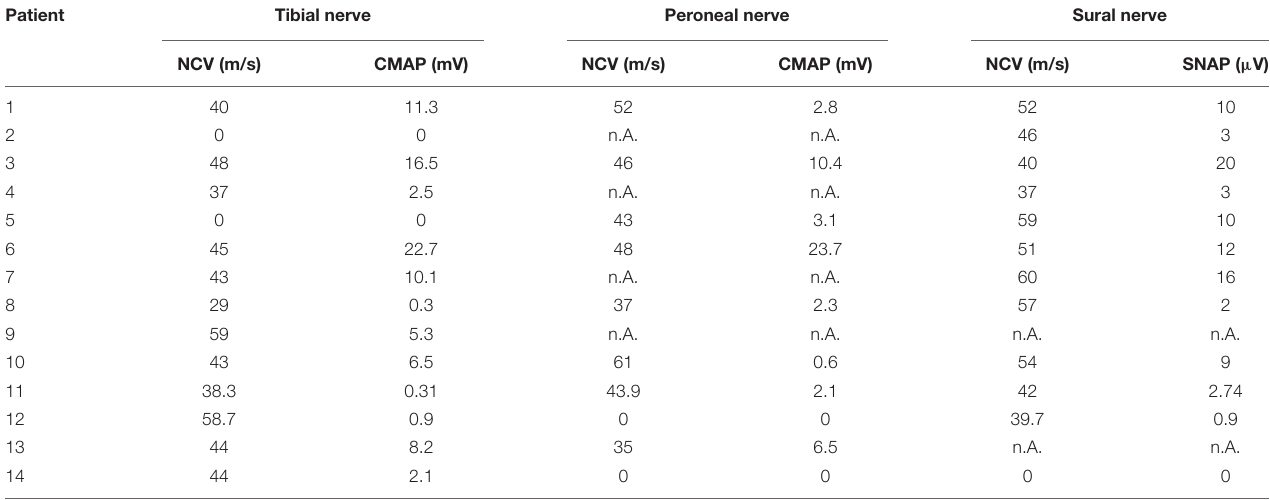
TABLE 2 | Electrophysiological data. Patient Tibial nerve